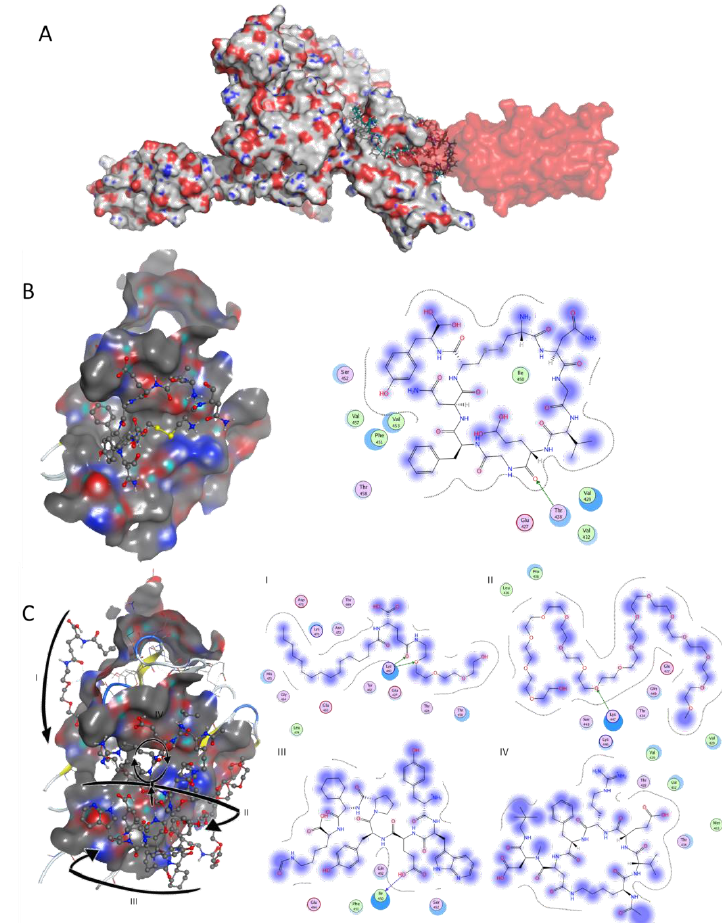
Figure 2. Docking studies on GRP78 SBD. ( A ) 3D surface structure of GRP78 (pdb code 5e84) (grey surface) bound to SARS-CoV-2 (red transparent surface); the C480–C488 section of the whole SARS-CoV-2 spike (pdb code 6m0j) was aligned with the docked C480–C488 in order to allow an easier visualization of the position of the spike towards the GRP78 target. Known peptide Zilucoplan is shown in sticks for exemplification. ( B ) SARS-CoV-2 region IV, and ( C ) known drug Zilucoplan bound to GRP78 SBD in 3D representation (left image, with arrows representing the direction of the peptidic strand from the linear—I, II, III—to the macrocyclic segment—IV) and respective 2D interaction scheme (right image). The polar and non-polar amino-acids are shown in pink and green circles; hydrogen bonding is indicated by dotted arrows; proximity contour are dotted lines surrounding the ligand, indicating the shape of the binding site and available space to the more outward-facing parts of the ligand; blue shadows in some amino acids indicate the receptor exposure differences by the size and intensity of the quoits disks. The directions of the shadows indicate the directions of the amino acids toward the ligands. The blue clouds around the ligand atoms indicate the solvent